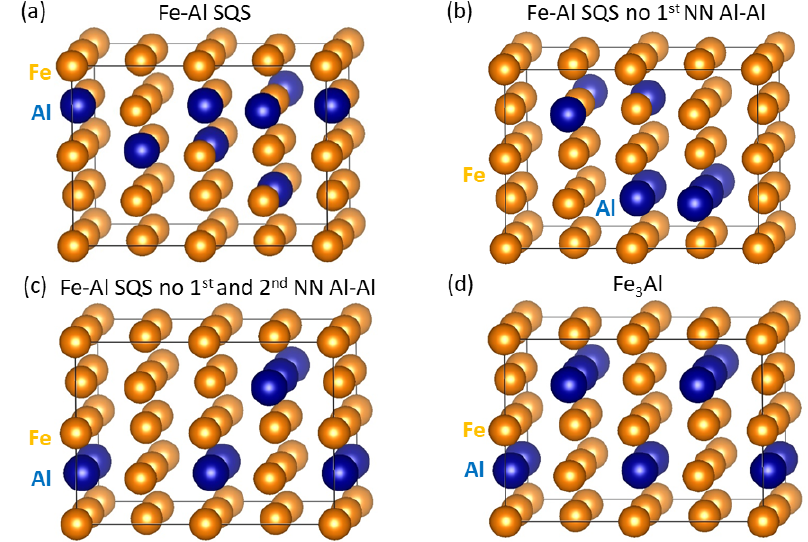
Figure 1. Schematic visualization of the 32-atom supercells used in our calculations: ( a ) a general special quasi-random structure (SQS) model for the Fe-Al phase (with 18.75 at.% Al), ( b ) an SQS model for the Fe-Al phase without any 1st nearest-neighbor (NN) Al-Al pairs, ( c ) an SQS model for the Fe-Al phase without the 1st and 2nd NN Al-Al pairs and ( d ) a 32-atom supercell of the Fe 3 Al intermetallics. The unrelaxed atomic positions are listed in Table A1 in the